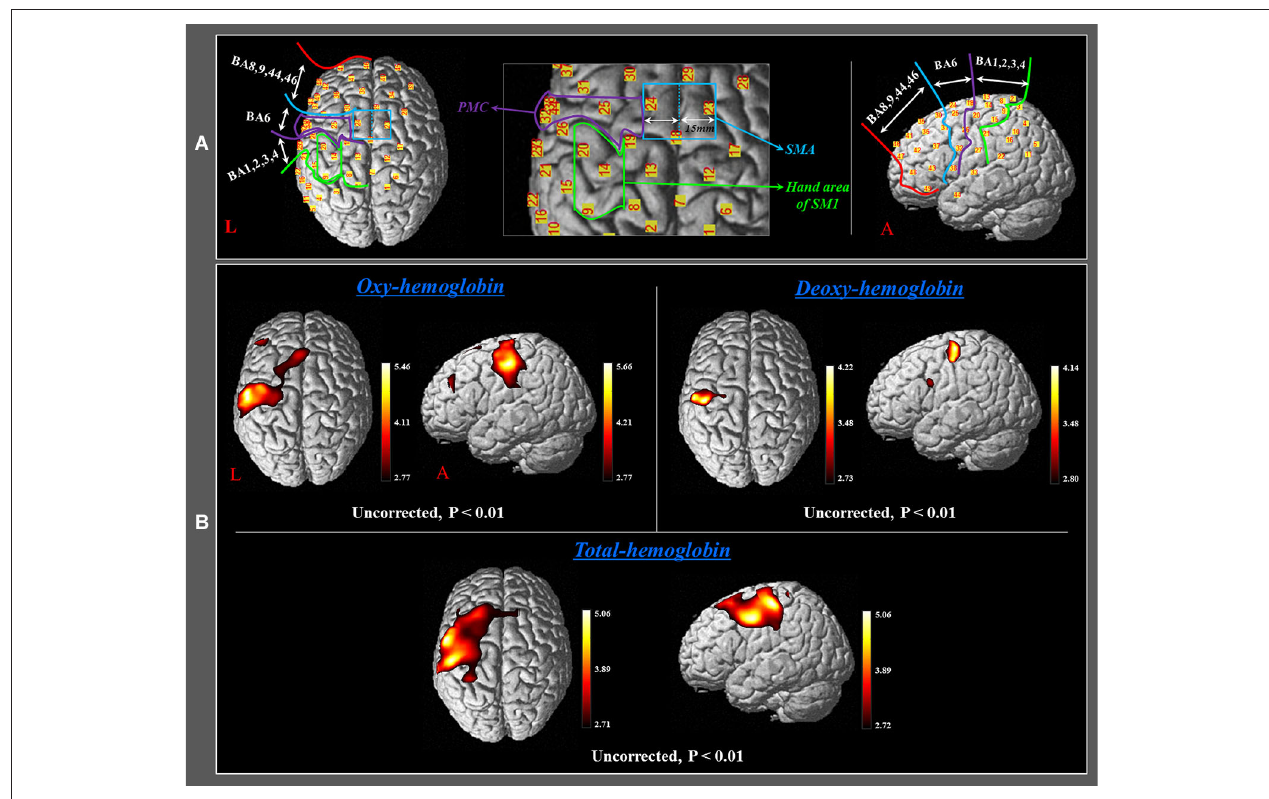
hemispheres, lateral boundary: the line 15 mm lateral from the midline between the right and left hemispheres); prefrontal cortex (PFC): BA 8, 9, 44, 45, and 46. (B) Group-average activation map of HbO, HbR, and HbT during performance of passive movements of the right fingers, which were executed by the rehabilitation robotic hand using NIRS-SPM (uncorrected, p <